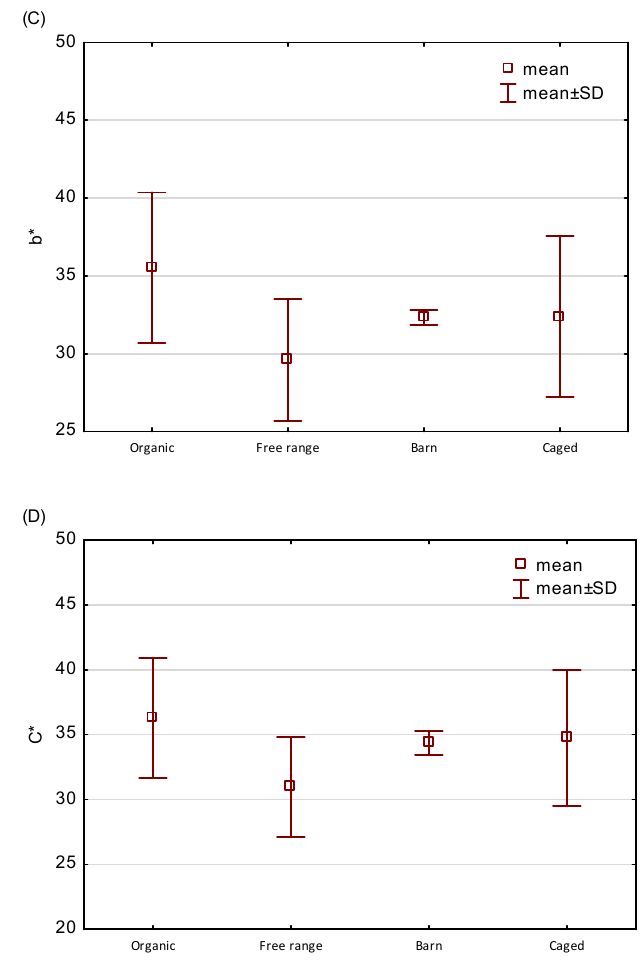
Figure 2. The effect of the farming system on the yolk color parameters ( A ) L*, ( B ) a*, ( C ) b*, and ( D ) C*.